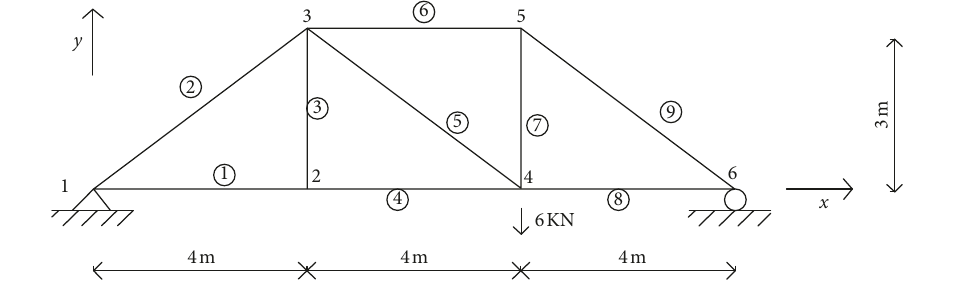
Figure 2: A three-bay truss structure. Table 1: Disassembled elements and the corresponding DOFs.